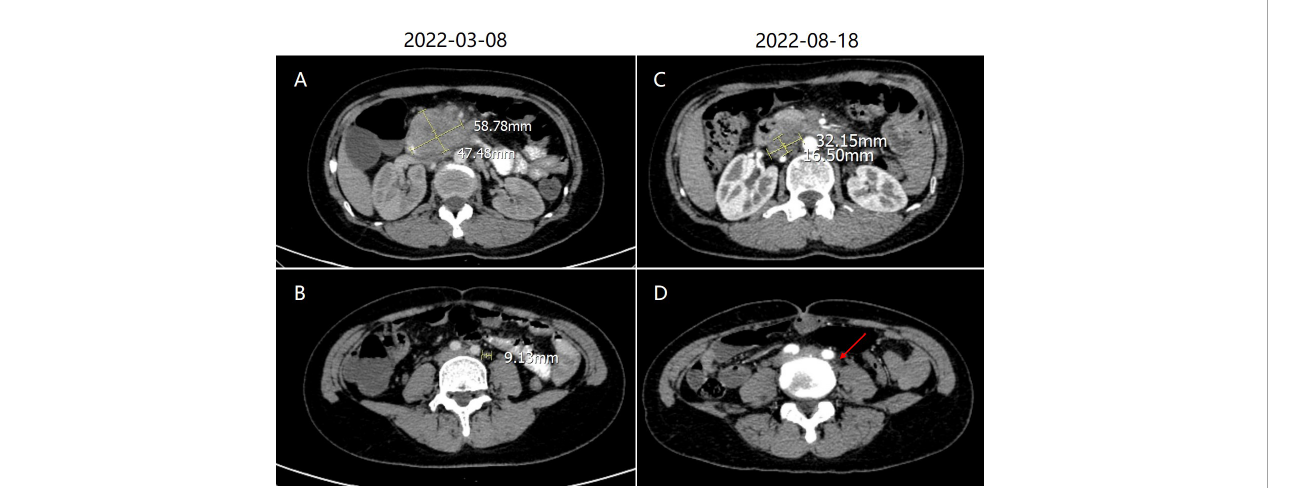
FIGURE 2 (A) Abdominal contrast-enhanced computed tomography (CT) showed a mass approximately 5.8 × 4.7 cm in size in the periampullary area. (B) The largest lymph node in the retroperitoneal space was approximately 1.0 cm in size. (C) After treatment, abdominal enhanced CT showed shrinkage of the primary lesion. (D) The largest lymph node also shrank (red